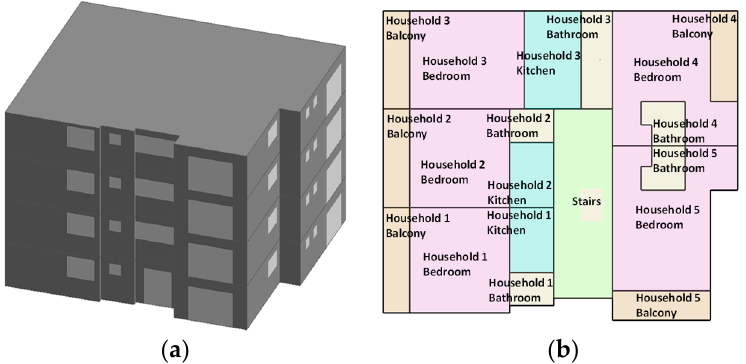
Figure 2. 3D model and configuration of the dormitory building. ( a ) 3D model; ( b ) Configuration.